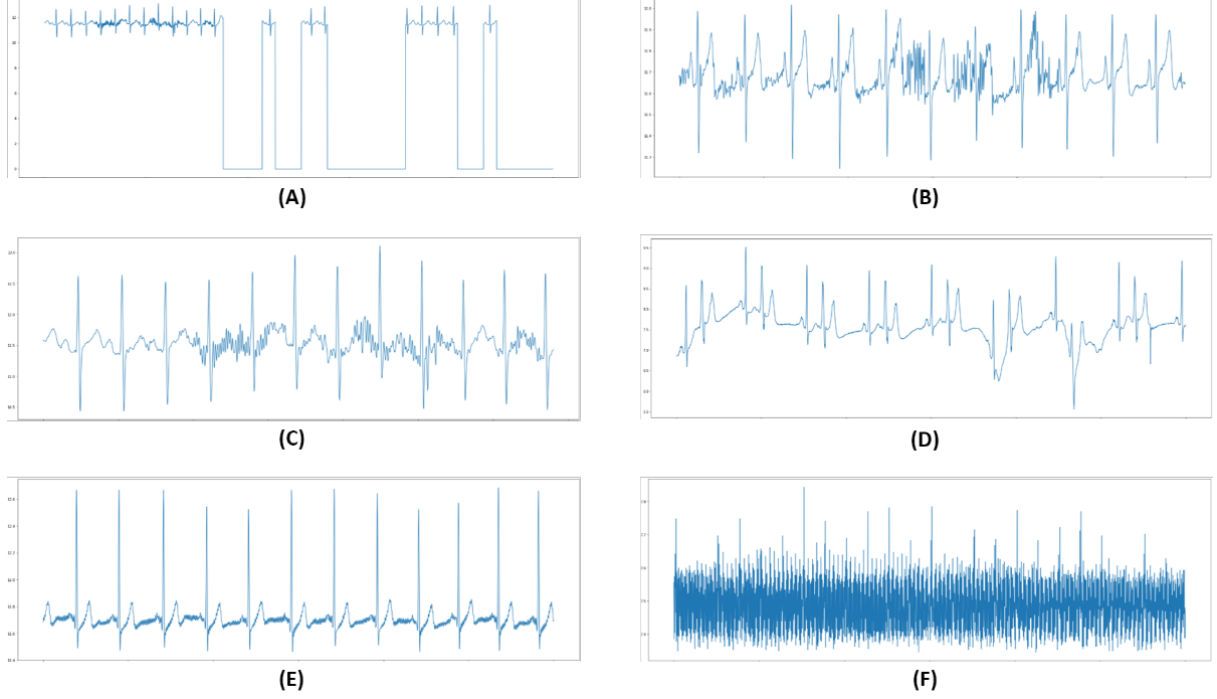
Figure 3. Examples of electrocardiographic signal noise: (A) loose contact, (B) motion artifact, (C) muscular activation interference, (D) baseline wandering, (E) alternating current (AC) interference (low signal-to-noise ratio), (F) AC interference (high signal-to-noise